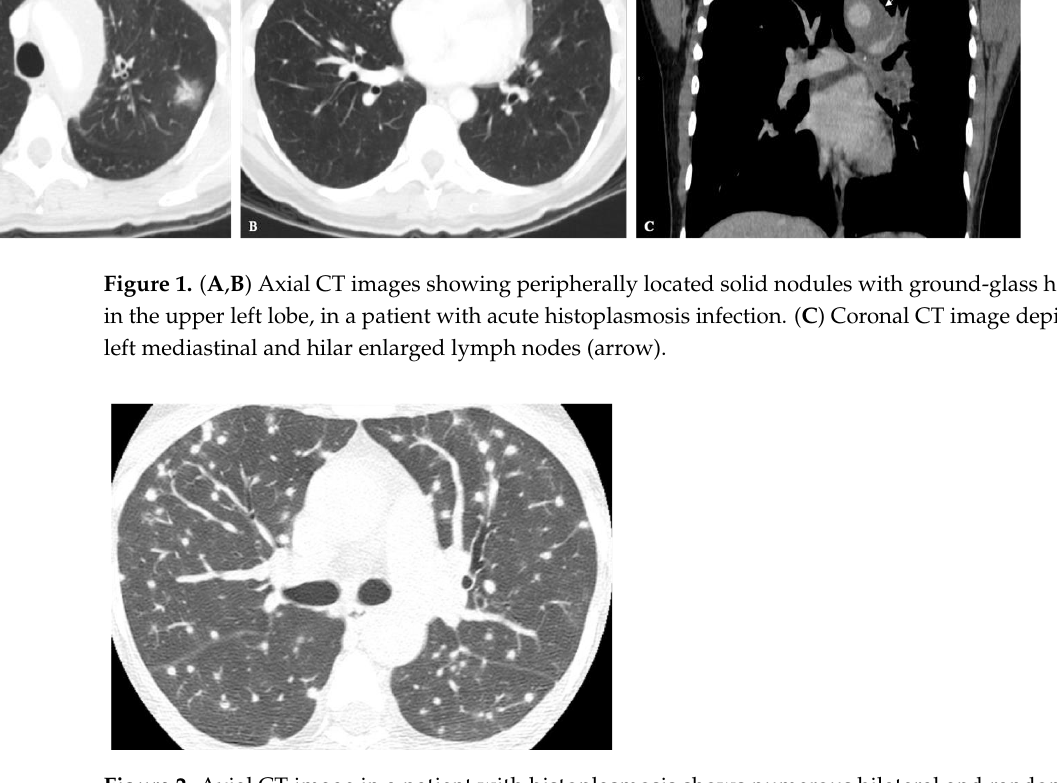
Figure 2. Axial CT image in a patient with histoplasmosis shows numerous bilateral and randomly distributed solid nodules, some of them with peripheral ground-glass halos.